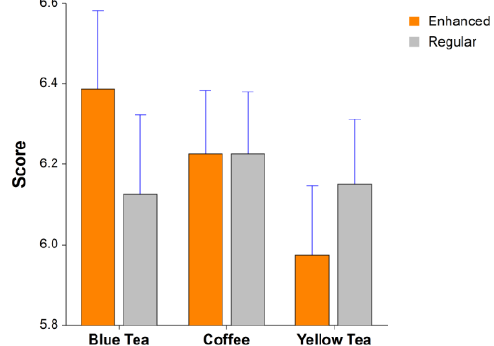
Figure 3. Comparison of perceived confidence in task performance (self-reported rating). Whiskers represent the